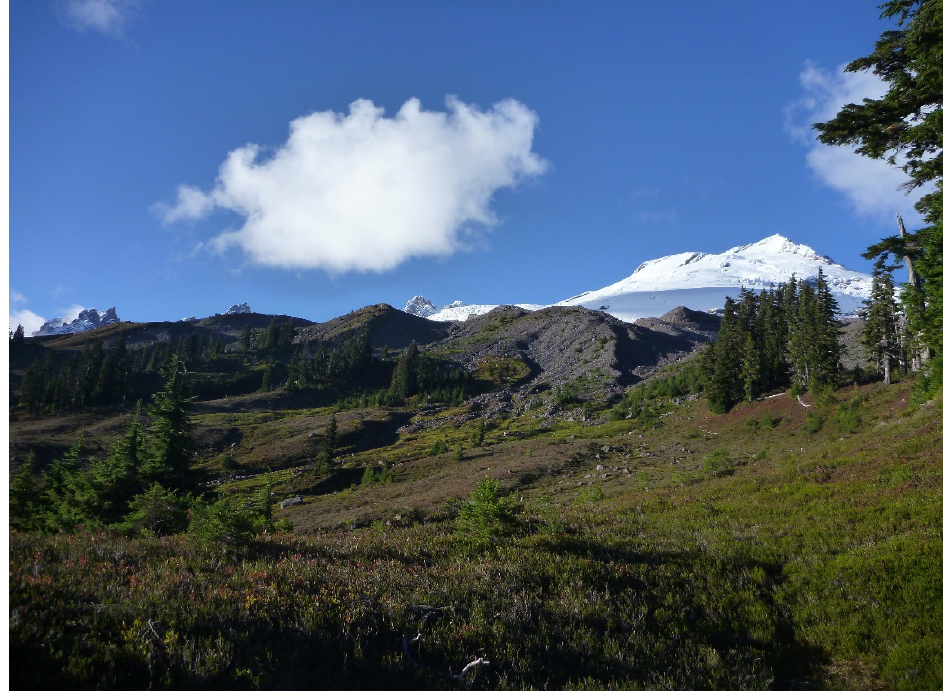
Figure A4. End moraines above the Scott Paul site and the uneven terrain below them left by previous mass wasting events.